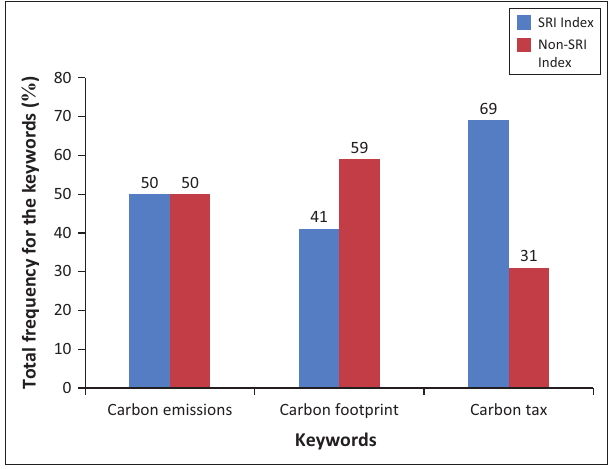
FIGURE 4: Socially Responsible Investment Index and Non-Socially Responsible Investment Index contribution to carbon emissions, carbon footprint and carbon